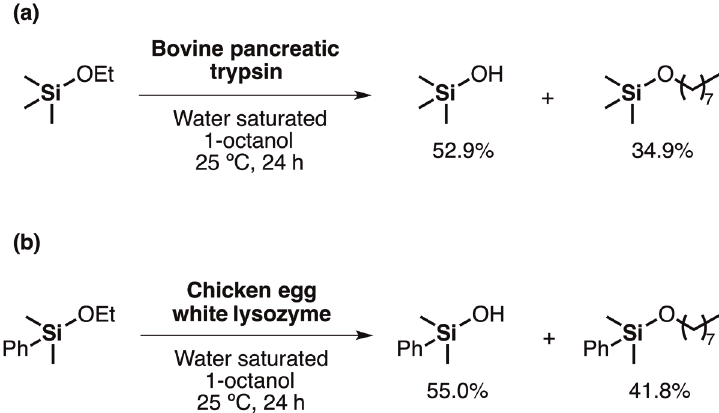
Figure 59 - Enzyme-catalyzed transetherification and/or alcohol-silanol